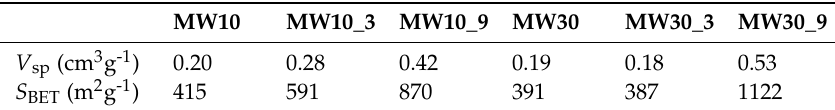
Table 3. Textural data of samples shown in Figure 5.